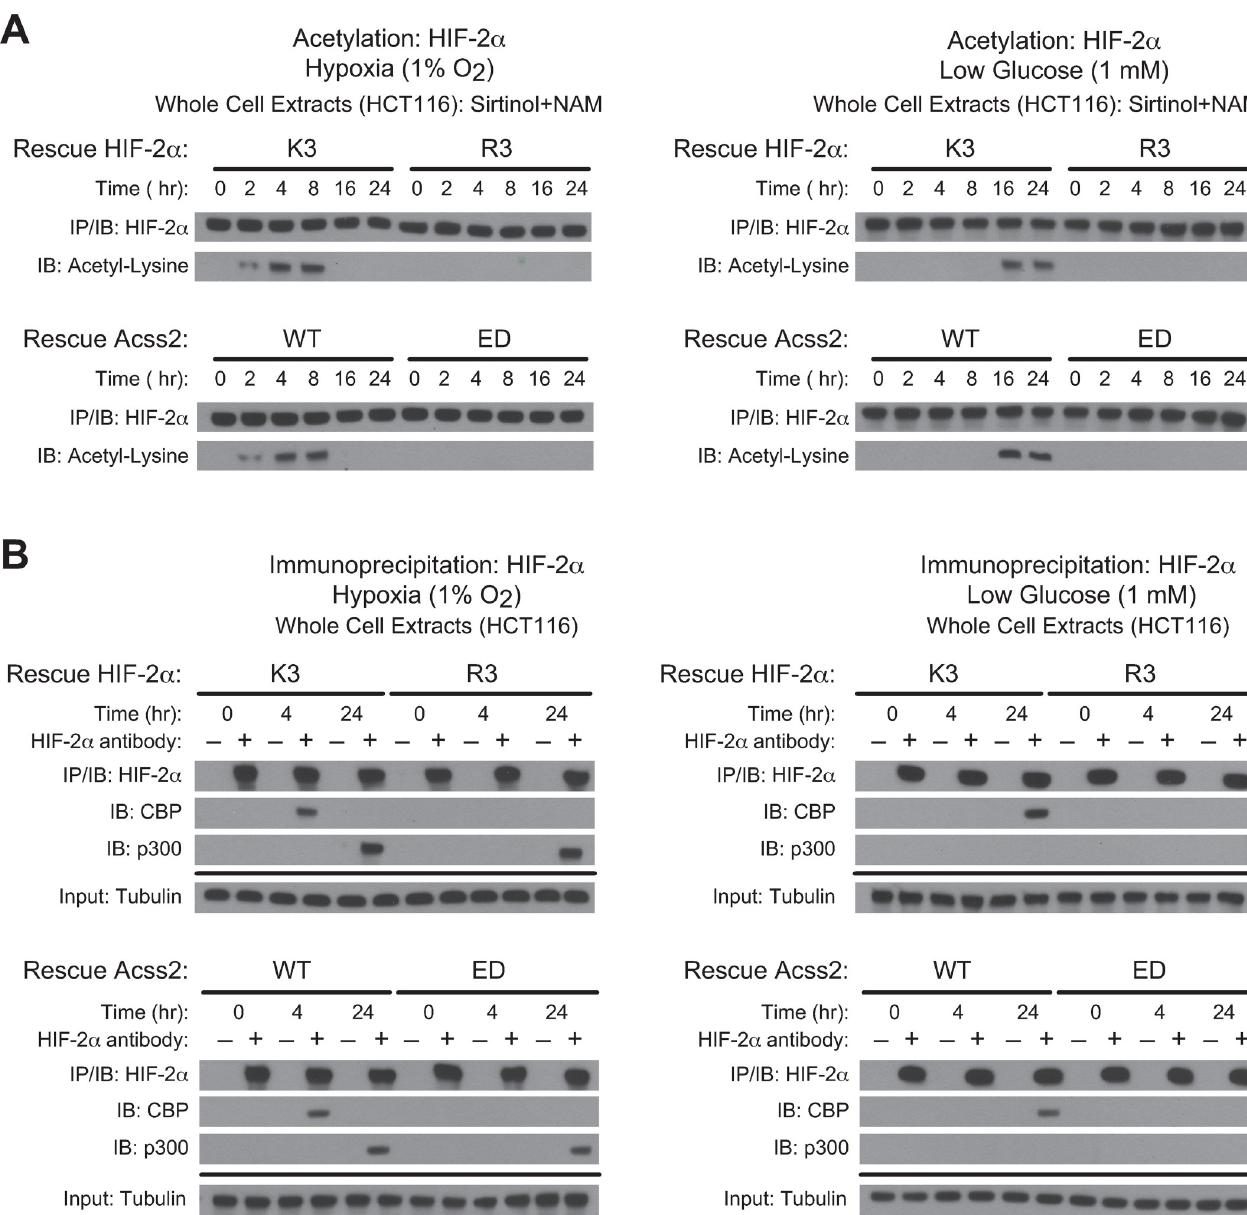
Fig 3. Acss2/Cbp/HIF-2 α interactions in HCT116 cells. (A) Acetylation detected by immunoblotting (IB) of ectopic HIF-2 α in HIF-2 α knockdown HCT116 cells rescued with wild-type (K3) or arginine-lysine substituted mutant (R3) HIF-2 α (upper panel), or of endogenous HIF-2 α in Acss2 knockdown